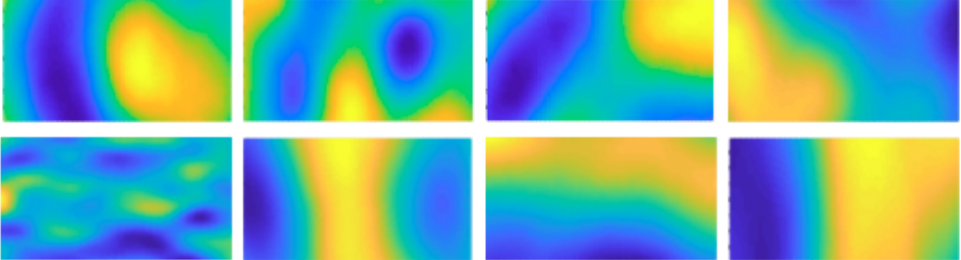
Figure 1. The eight MWT image samples in our study [8]. Different colors represent different foam moisture levels. Blue is the desired color, representing lower moisture